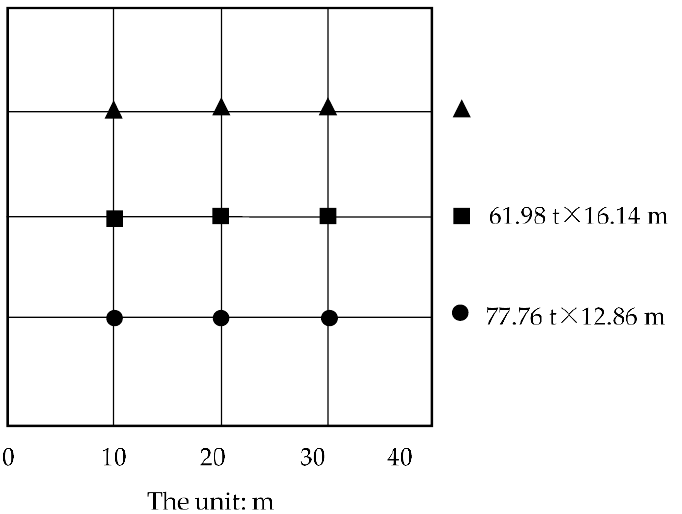
Figure 4. Layout of impact points in the test zone.